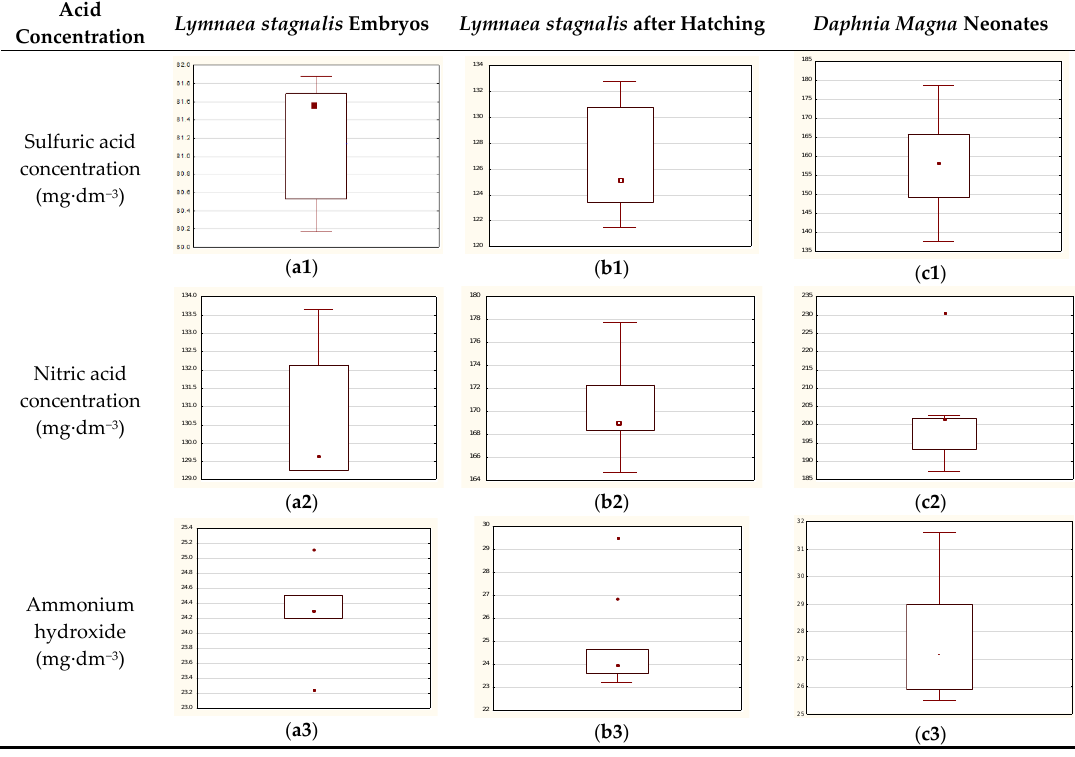
Figure 3. LC 50 (24 h) values for selected bioindicators exposed to various concentrations of stressors: ( a ) Lymnaea stagnalis embryos; ( b ) Lymnaea stagnalis juvenile forms; and ( c ) Daphnia magna neonates Legend: median (plot central point), 25%–75% (box), non-outlier value (whiskers), and outlying points (extreme values). Table 5. Assessment of acute toxicity of pollutants on Lymnaea stagnalis embryos (LC 50 /24 h) Lymnaea stagnalis juveniles after